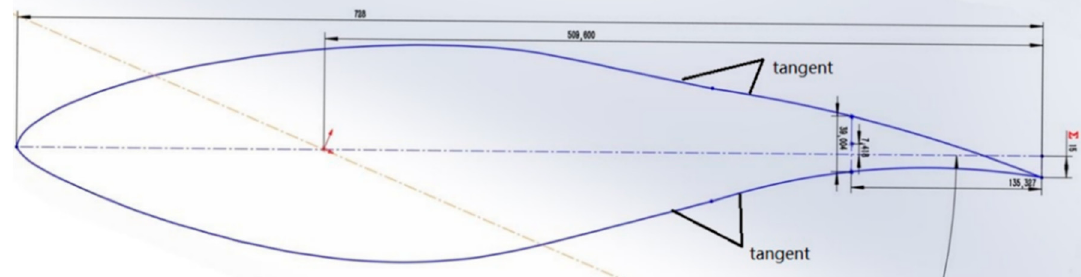
Figure 6. Cross section geometry. Table 1. Discrete input parameters in parameter